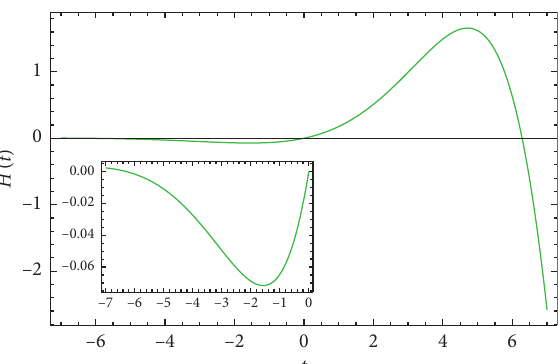
Figure 12: Evolution of the Hubble parameter for ω 0 . 5 ; r � − 0 . 0005 ; s �